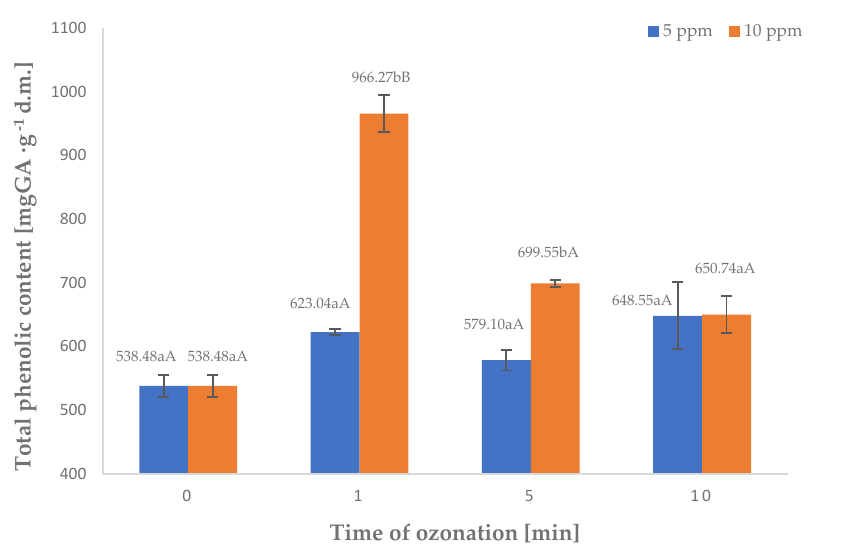
Figure 2. Total polyphenolic content in Kalanchoe daigremontiana leaves depending on the duration of ozone treatment (n = 20): differences between the results for duration of ozone treatment on specific days are marked with small letters, and differences between dose of ozone (ppm) measurements are marked with capital letters; significance level is defined as p < 0.05.